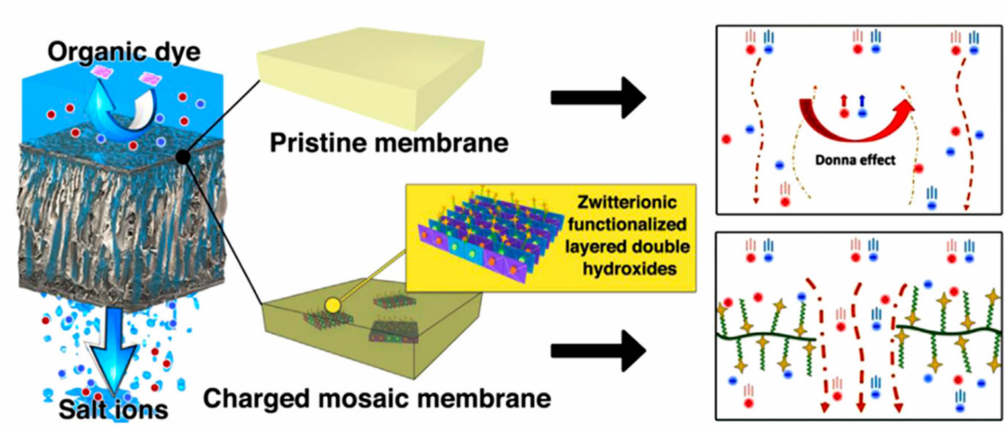
Figure 23. Schematic diagram for the separation mechanism of pristine membranes and charged mosaic membranes. Reproduced with permission from Reference